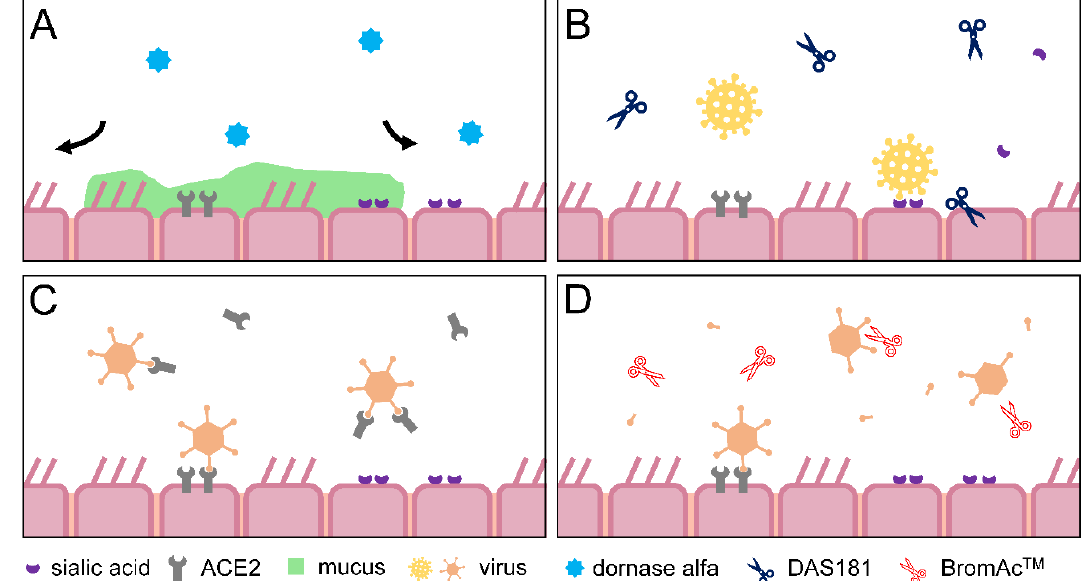
Figure 3. Schematic of proposed mechanisms of action for inhaled enzyme therapeutics in the respiratory tract. ( A ) dornase alfa cleaves extracellular DNA, reducing the viscosity of mucous and making it easier for the airways to clear the mucus. ( B ) DAS181 catalyses sialic acid cleavage from glycoproteins and glycolipids present on the lung epithelium, which interferes with the lifecycle of some viruses. ( C ) the ACE2 receptor is used by the SARS-CoV-2 virus to enter cells and administering ACE2 is expected to act as a decoy for the virus, preventing infection. ( D ) BromAcTM is purified bromelain combined with N-Acetyl Cysteine and is thought to break down the spike protein of the SARS-CoV-2 virus thereby eliminating the ability of the virus to infect cells. Abbreviations: ACE2, angiotensin converting enzyme 2; DNA, deoxyribonucleic acid.